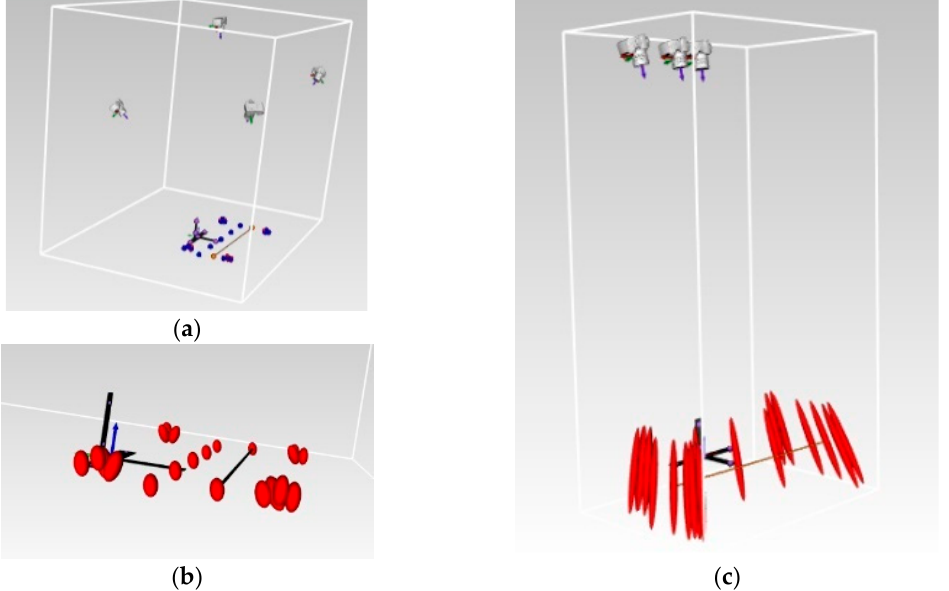
Figure 5. Network relevance: ( a ) An efficient network generates a narrow uncertainty (red ellipses). ( b ) Detailed view of ( a ). ( c ) A deficient network produces considerably larger uncertainty. Table 1. Results expected for the measurements of the reference wall from the four scenarios in- vestigated.